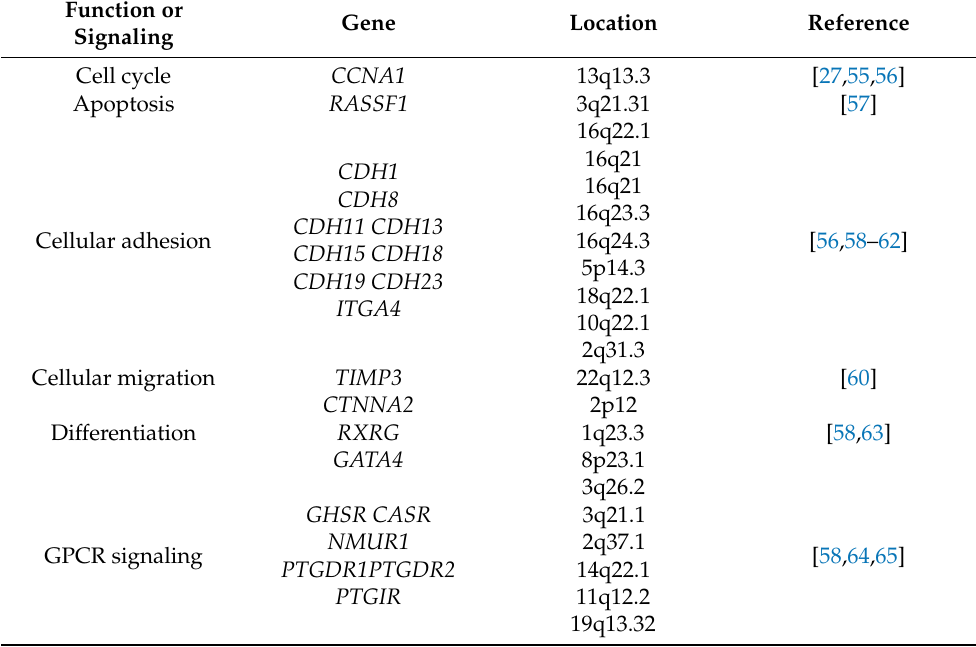
Table 1. Frequently hypermethylated genes in human papillomavirus-associated head and neck squamous cell